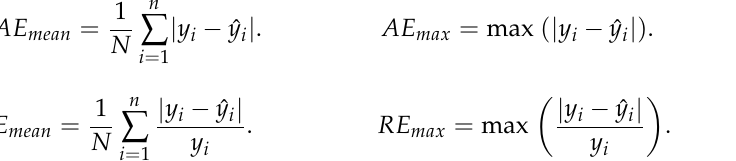
(cid:16) = f t / D b , n , Π δ p , x V